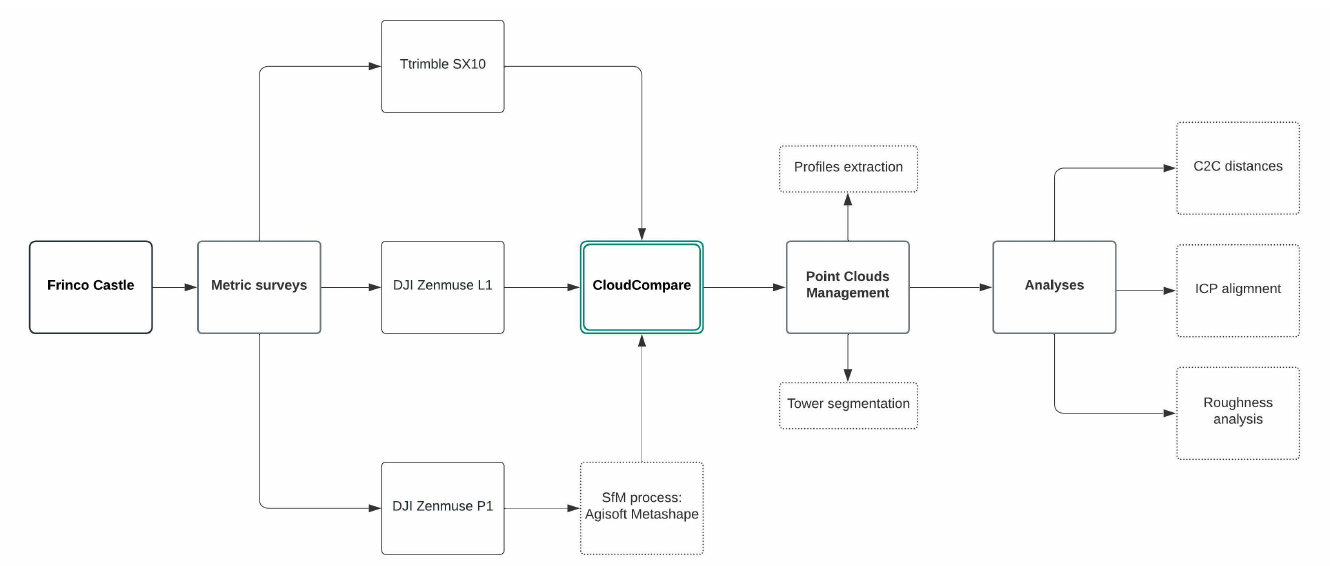
Figure 1. Workflow applied for this project: from metric surveys to point cloud management and